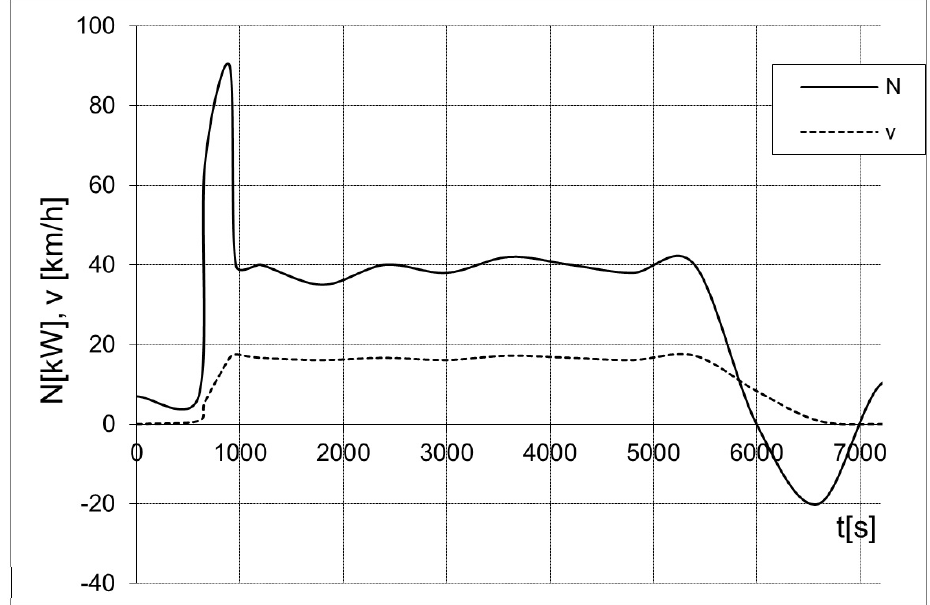
Figure 1. Exemplary operation cycle of intercity bus ( N : power; ω : angular velocity) [2,23,24].